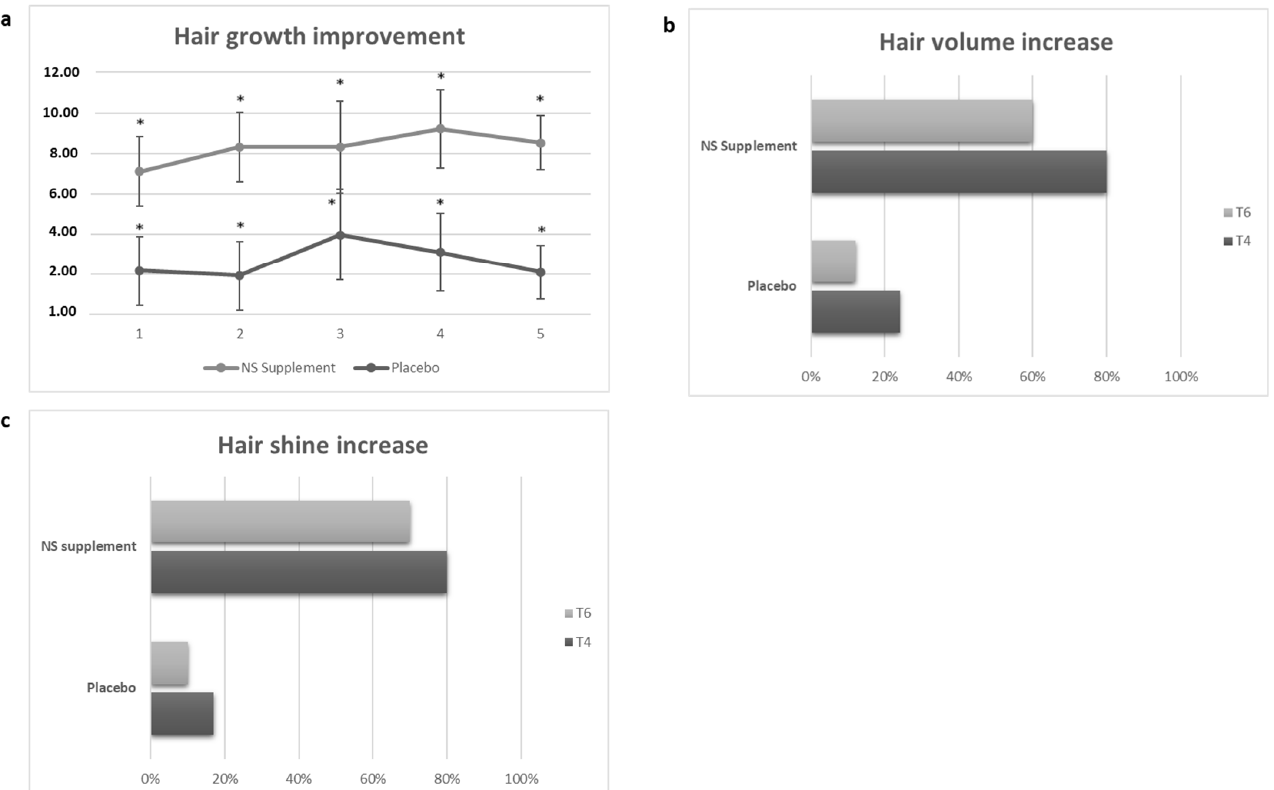
Figure 1. Percentage of participants with some improvement under items evaluated in both groups after 90 days (T4) and 150 days (T6). ( a ) hair growth, ( b ) hair volume and ( c ) hair shine as evaluated by a self-assessment questionnaire by volunteers (0–10 scale). Asterisks indicate a sig-nificant difference to the control (* p < 0.05).